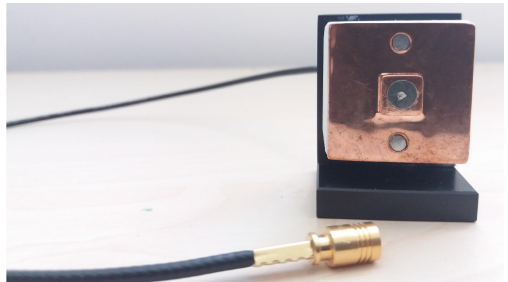
Figure 6. Illustration of the design of the copper housing and the printed electrode for the demonstrator setup; the electrical connection was realized through the central